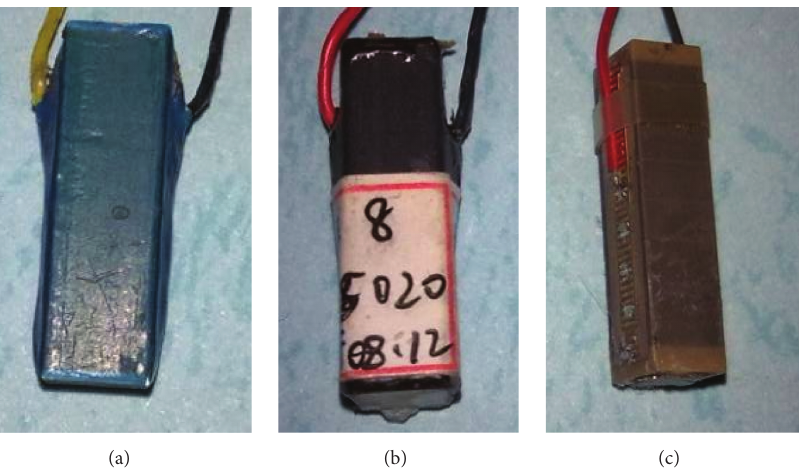
Figure 5: Photographs of the PSAs fabricated by (a) gluing piezoelectric wafers and electrodes (type: PTBS200), (b) sintering piezoelectric ceramic wafers and electrodes layer by layer (type: WYDS0808020), and (c) direct sintering piezoelectric ceramic wafers and electrodes as a whole (the cofired technology) (type: P885.51).